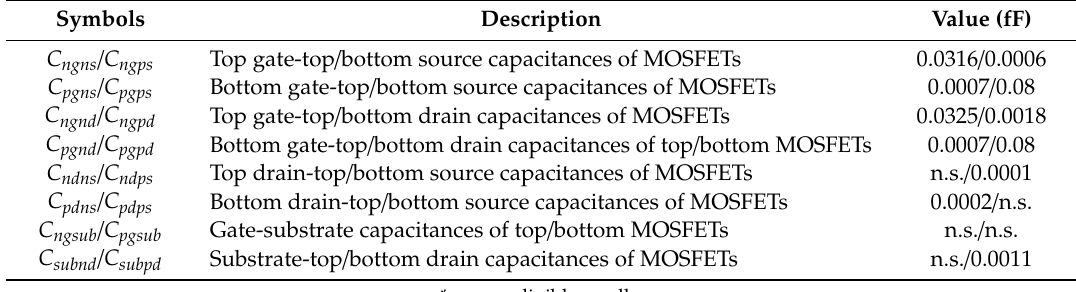
Table 2. Summary of internal and external capacitances.